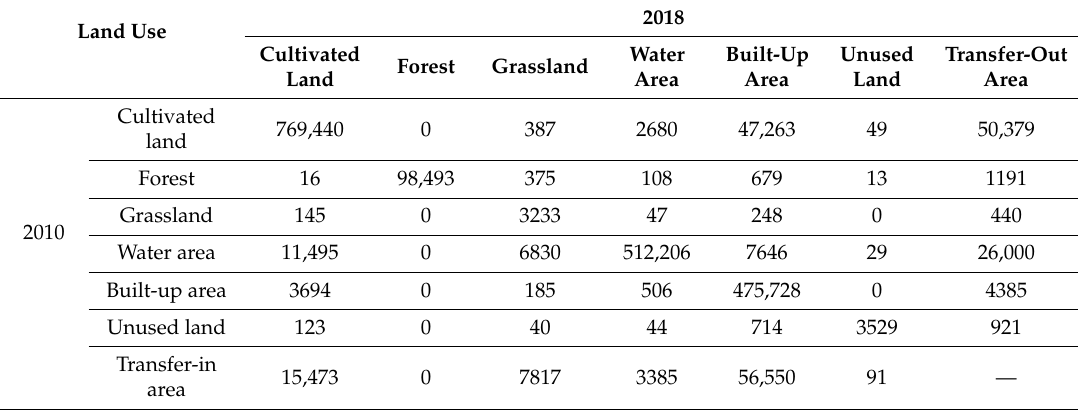
Table 6. Transition matrix of land-use change during 2010–2018 (ha).